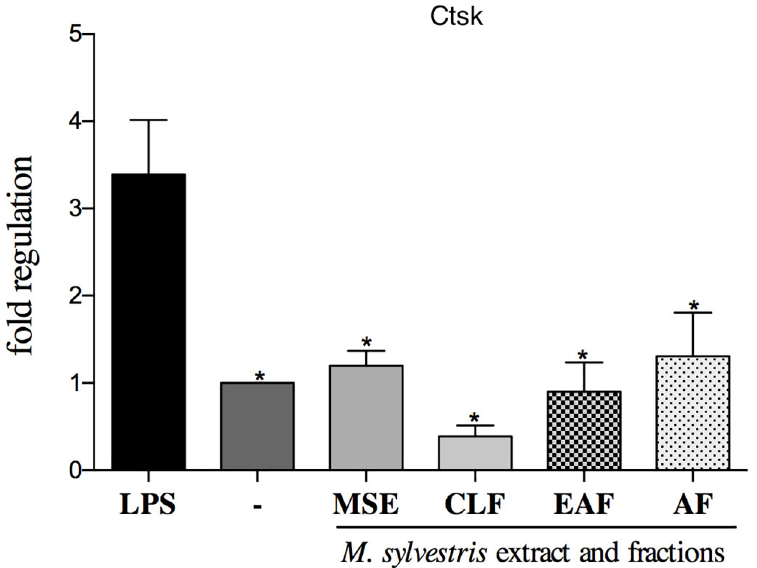
Fig 5. Effect of MSE and fractions on Ctsk (cathepsin K) expression levels. Quantification of the relative transcript amounts performed by qpcR with 10 ng of each cDNA. Data quantification was performed using 2 (-DeltaDeltaC(T)). Statistical analyses were performed by one-way ANOVA followed by Dunnett ’ s post-hoc tests. * p < 0.05 significantly different from LPS-stimulated cells.